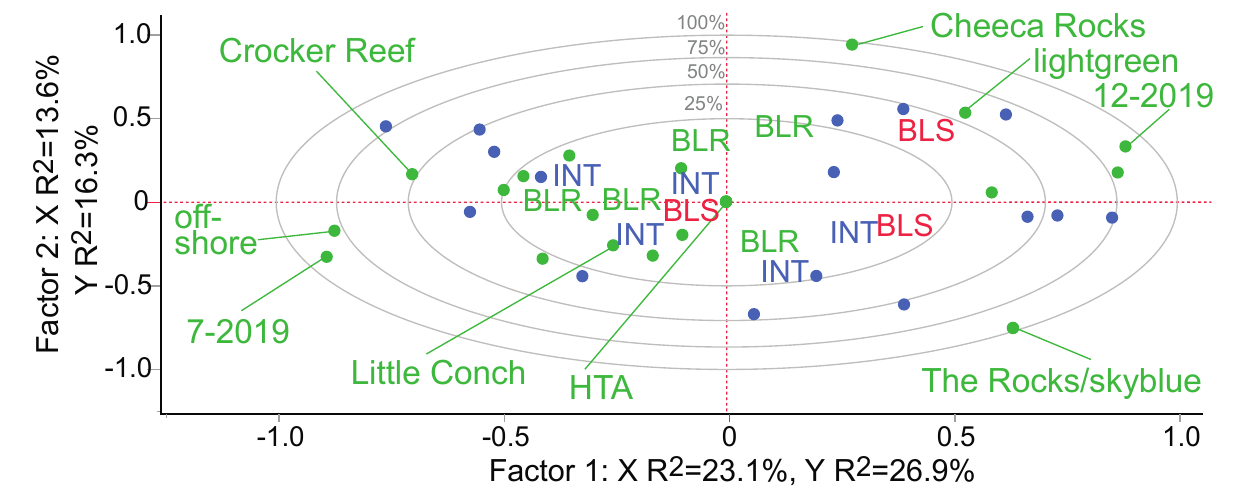
Figure 3. Partial least squares correlation loading plot. The 16 proteins measured in all field samples were the model Y’s (blue dots) while the following were considered as putative drivers of variation (green dots, of which several have been labeled): reef site (Cheeca Rocks, The Rocks, Little Conch, & Crocker Reef), shelf (inshore vs. offshore), date (Jul. & Dec. only), host genotype (black(a), black(f), black(g), black(i), black(r), skyblue, darkred, lightgreen, or unknown), fragment health designation (healthy control, high-temperature-acclimating [HTA], sub-lethally stressed, & actively bleaching), and colony health designation (CHD; bleaching-susceptible [BLS], bleaching-resistant [BLR], & in- termediate [INT]). The samples themselves are labeled by their CHD (red, blue, & green for BLS, INT, & BLR, respectively) and include only 13 biopsies since only training data are shown.